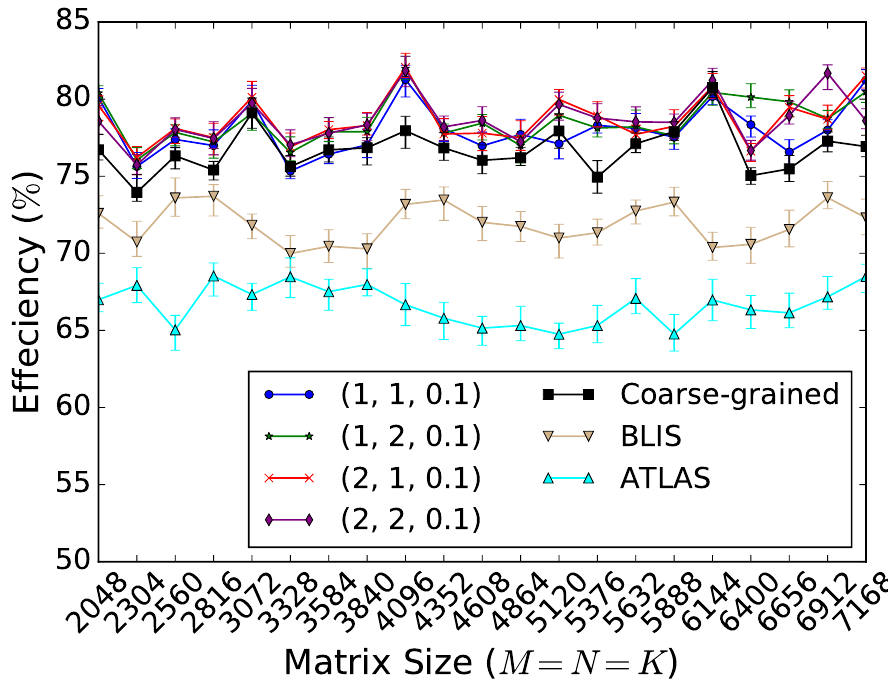
Figure 5. GEMM performance (64 threads). Hybrid-grained implementations are labeled with ( n s , n d , g ) .